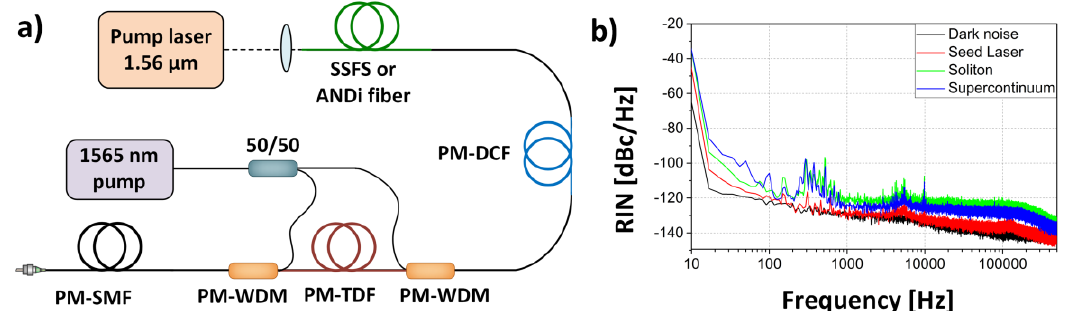
Fig. 1 Schematic of the experimental setup (ANDi – all-normal dispersion fiber, SSFS – soliton self-frequency shift fiber, PM-DCF – polarization maintaining dispersion compensating fiber, PM-WDM – PM wavelength